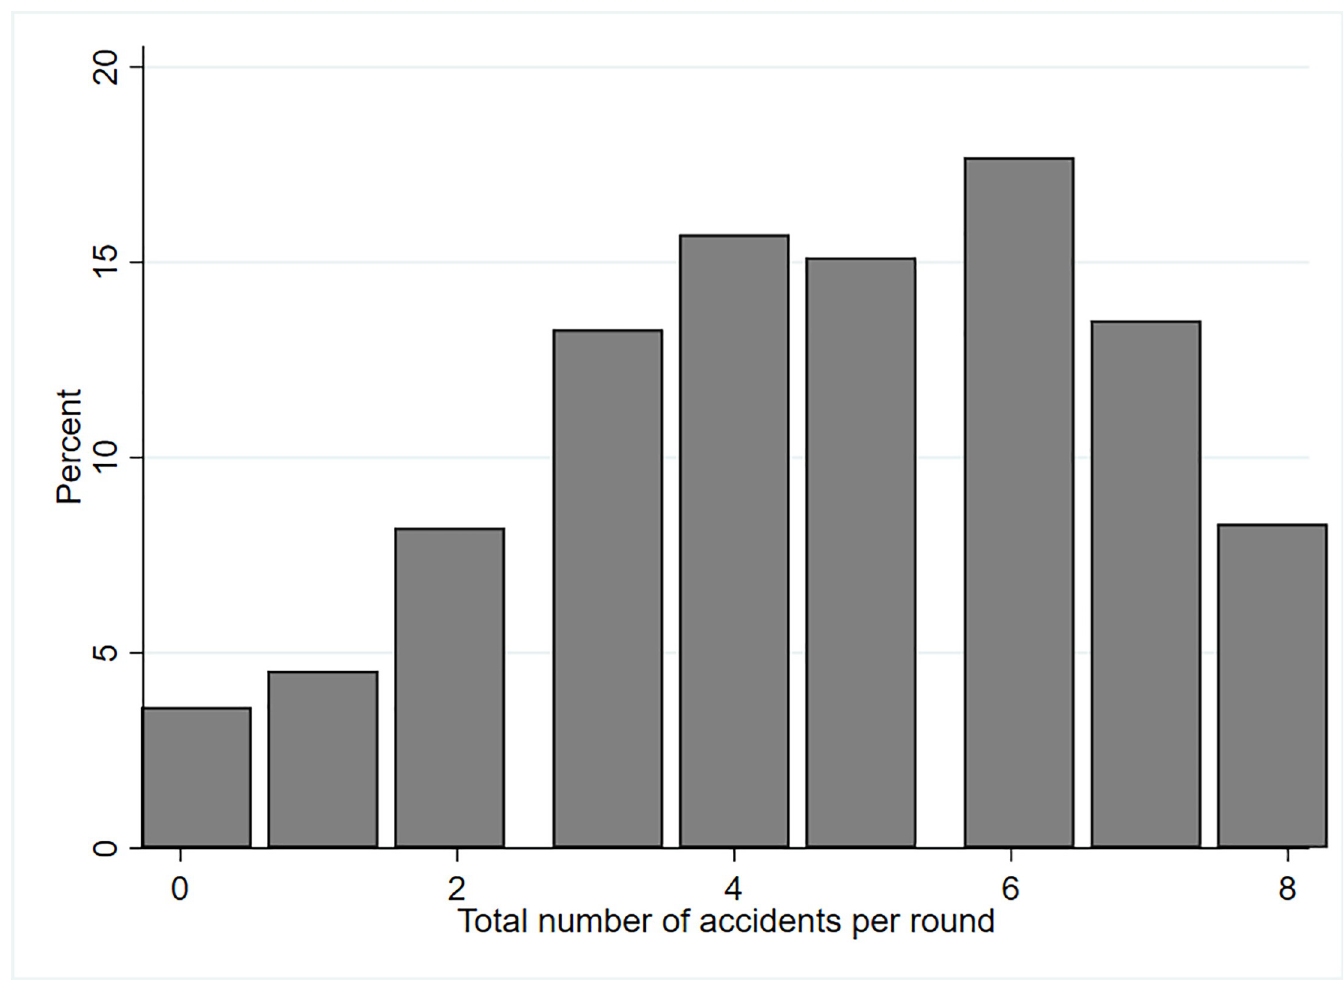
Fig 4. Total number of accidents per